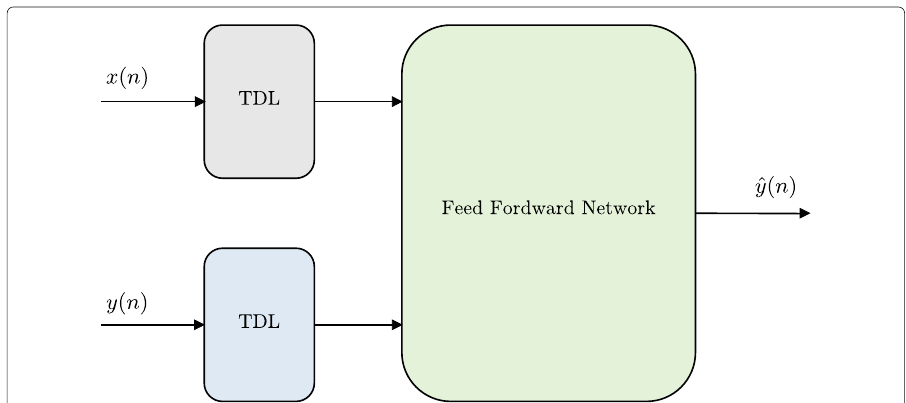
Fig. 7 A NARX network with series-parallel architecture. The taped delay line (TDL) blocks introduce past values (memory effect) of the input and output signals to the